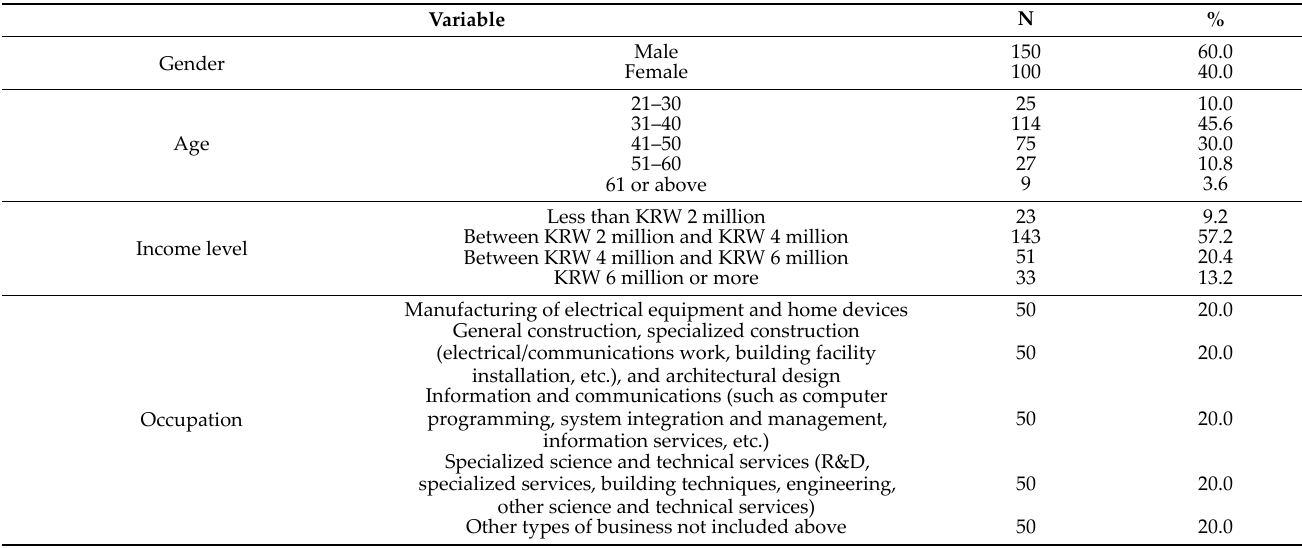
Table 3. Demographic characteristics of the